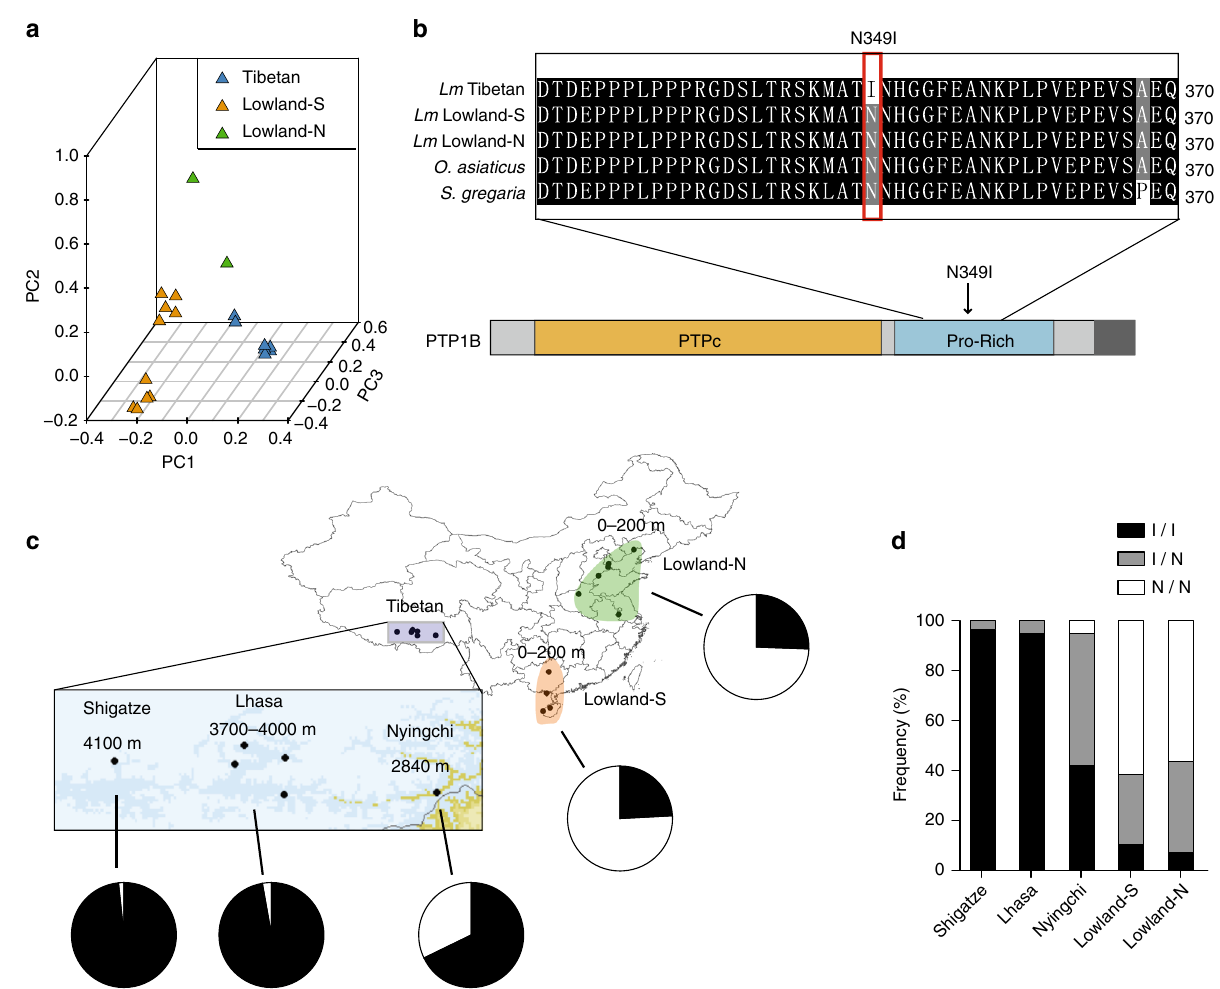
Fig. 3 Genetic differentiation of PTPN1 . a Principle component analysis plot of geographically different locust populations based on the SNPs of the PTPN1 gene region. Lowland-S and Lowland-N represent South and North China lowland locust populations, respectively. b Multi-species alignment of amino acid sequence of PTP1B encoded by PTPN1 . Oedaleus asiaticus and Schistocerca gregaria are two outgroup species closely related to Locusta migratoria (abbreviated as Lm ). The missense mutation p.Asn349Ile (N349I) is located at the proline-rich (Pro-Rich) domain of PTP1B. c Mutation frequency of p. Asn349Ile in Tibetan and lowland locusts. The pie chart shows the proportion of p.Asn349Ile allele frequency in each population. Sample size: n ≥ 38. d Allele frequency of mutant loci in PTP1B. I/I, I/N, and N/N represent homozygous wild type, heterozygote mutant, and homozygous mutant for p. Asn349Ile, respectively. Maps were generated using DIVA-GIS